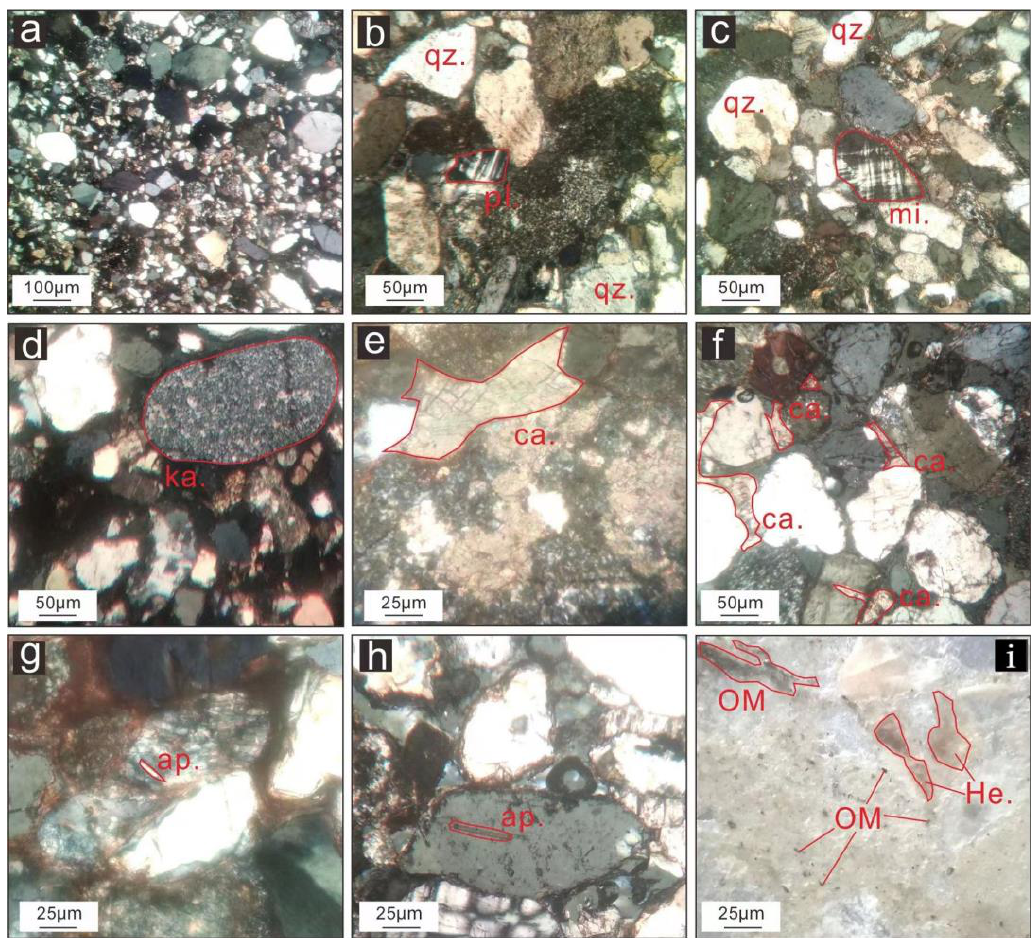
Figure 5. Polarized light micrographs of sandstone samples. Note: qz. = quartz; pl. = plagioclase; mi = microcline; ca. = calcite; ap. = apatite; ka. = kaolinite; He. = hematite; OM = organic matter. ( a – c , e – g , i ) for fresh sandstone samples. ( d , h ) for weathered samples.